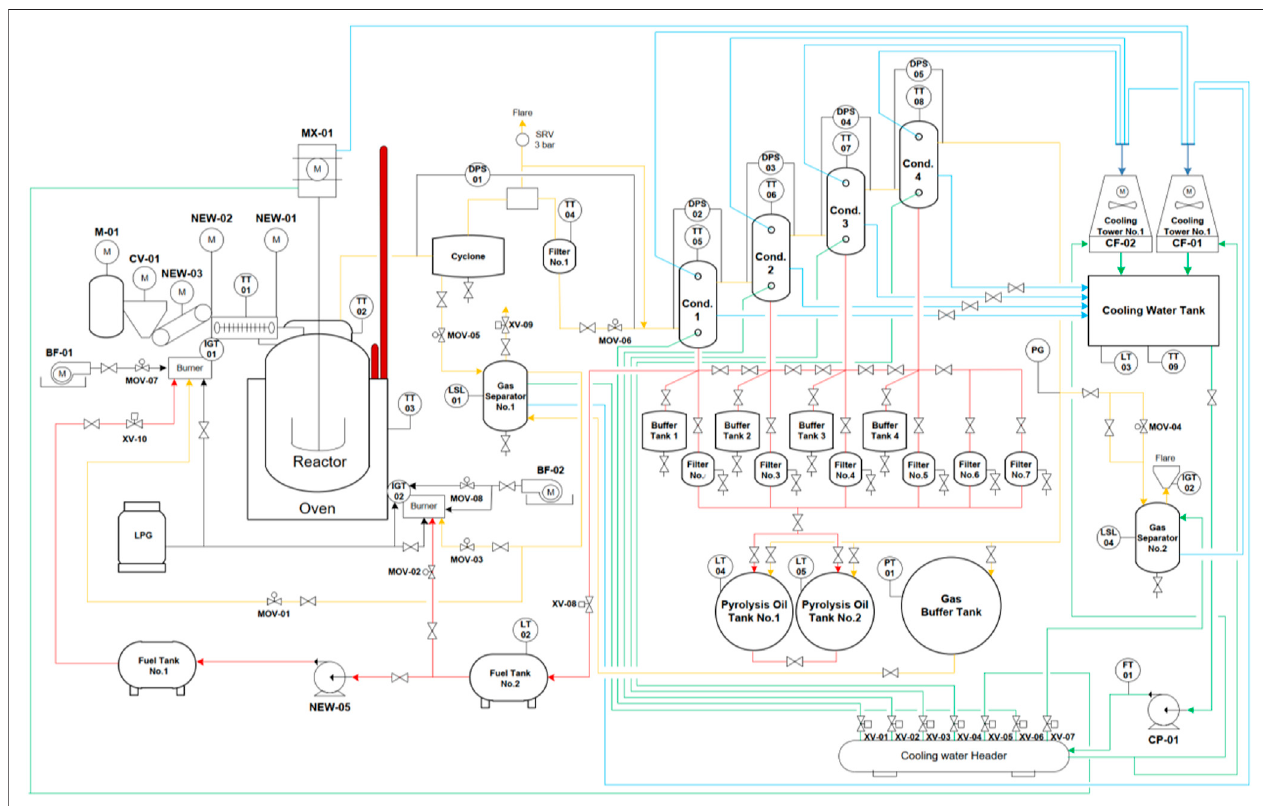
FIGURE 6 | Mobile pyrolysis process fl ow diagram.